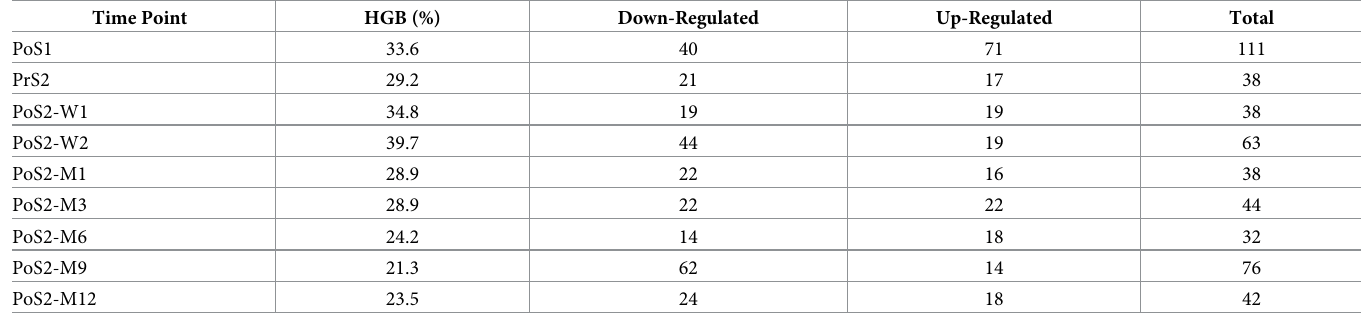
Table 3. Summary of differentially expressed genes with corresponding HGB content prior to removal of HBA1, HBA2, HBB, HBD, HBG1, HBG2, HBE1, HBM, HBQ1, HBZ transcriptomes bioinformatically, using Ensembl annotations. On average, ~ 29% of reads were related to HGB. Time